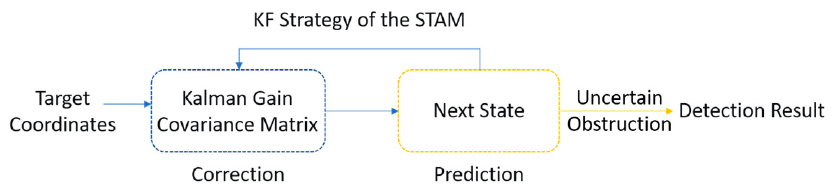
Figure 11. KF utilizes the motion correlation of the object to estimate the position [36,37]. When the obstruction is over, the model can quickly switch to the local search. As the parameters passing into the KF are only the positions, the computation does not consume many resources.